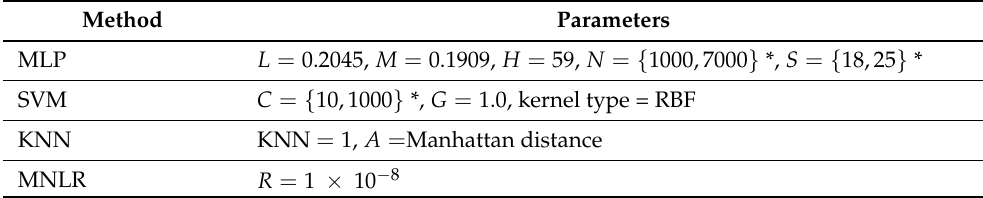
Table 12. Third experiment: classifiers’ configuration for the first